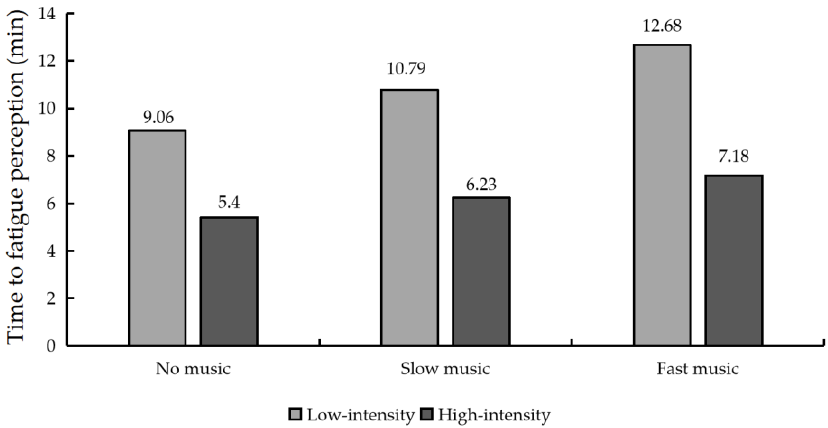
Figure 4. Time to fatigue perception for different experimental conditions.